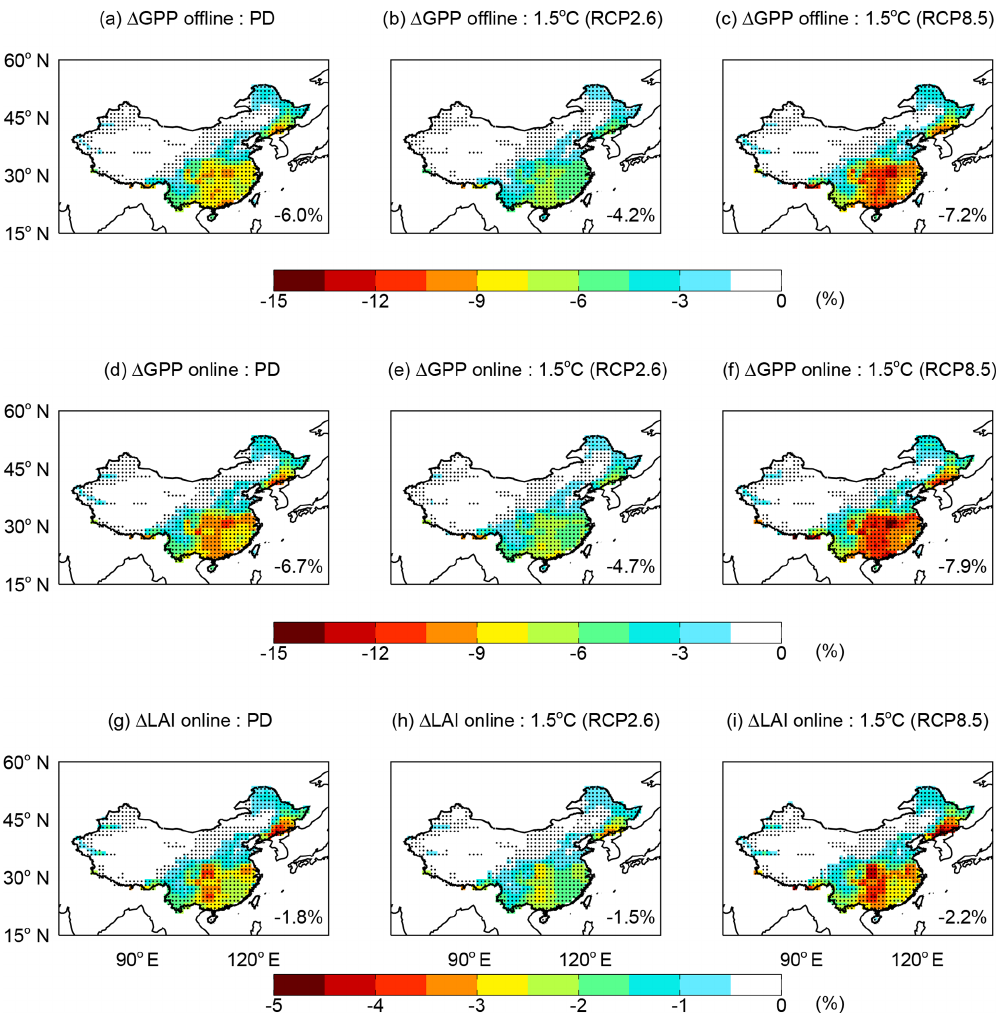
Figure 7. Damaging effects of O 3 to photosynthesis and plant growth. Results shown are ensemble mean changes in (a–c) offline GPP, (d–f) online GPP, and (g–i) leaf area index (LAI) caused by O 3 in the (a, d, g) present day (1995–2015) and 1.5 ◦ C warming under (b, e, h) RCP.6 (2050–2070) and (c, f, i) RCP8.5 (2021–2041) scenarios. The simulations are performed with the YIBs vegetation model driven with meteorology from 7 CMIP5 models and hourly ozone derived from 12 ACCMIP models. The damaging effect is averaged for high and low O 3 sensitivities. For each grid, significant changes at p < 0 . 05 are marked with dots. The mean changes over China are shown in each panel.